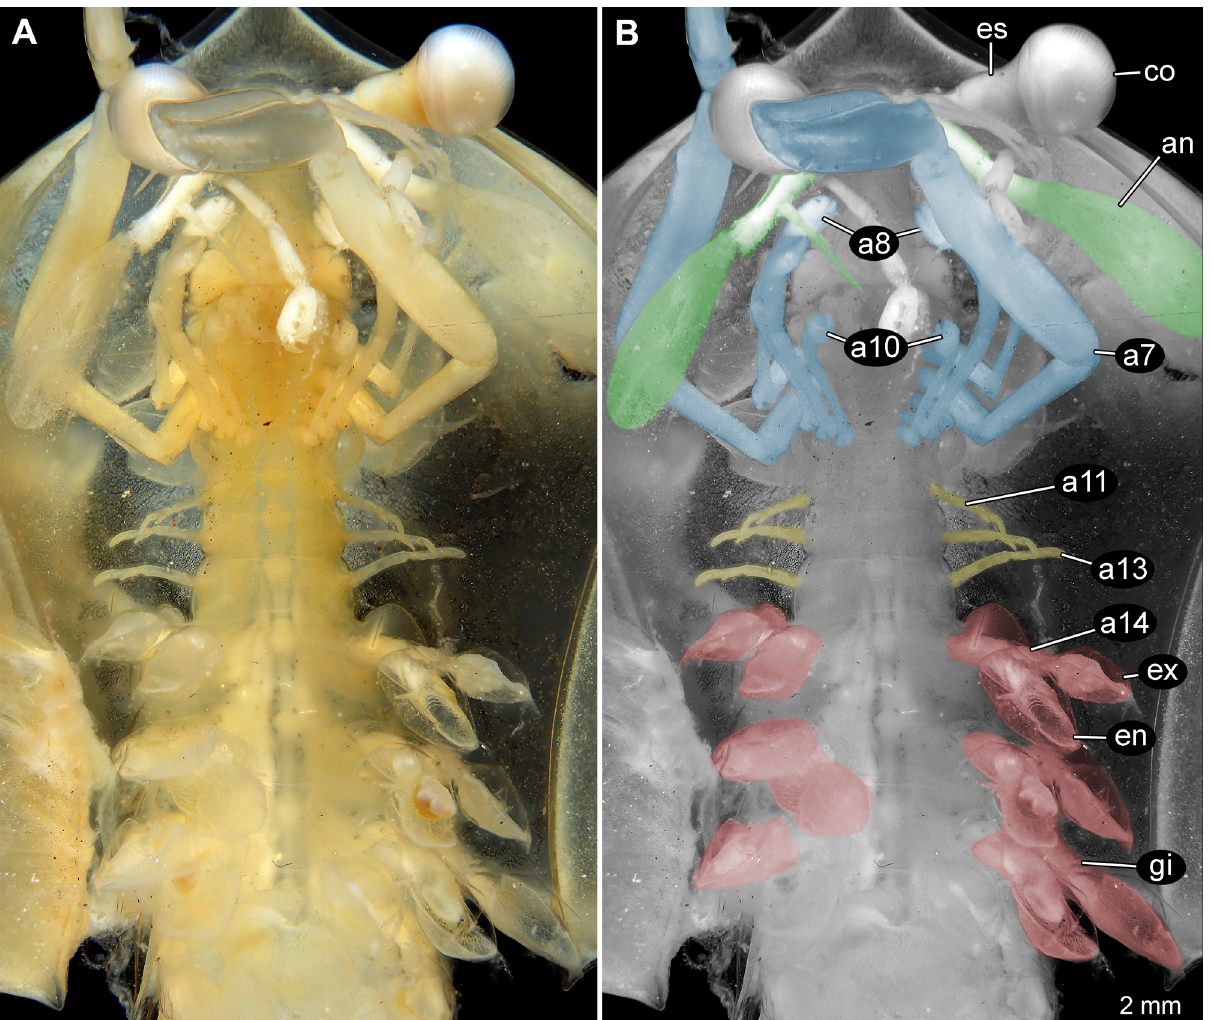
Figure 4. Ventral details of the new larval mantis shrimp specimen 30023A. A. Macro-photograph. B. Colour-coded version of A for identifying the outlines of the structures. Abbreviations: a7–14 = appendage of post-ocular segment 7–14 (= maxillipeds 2–5, thoracopods 1–3, pleopod 1); an = antenna; co = cornea; en = endopod; es = eye stalk; ex = exopod; gi =